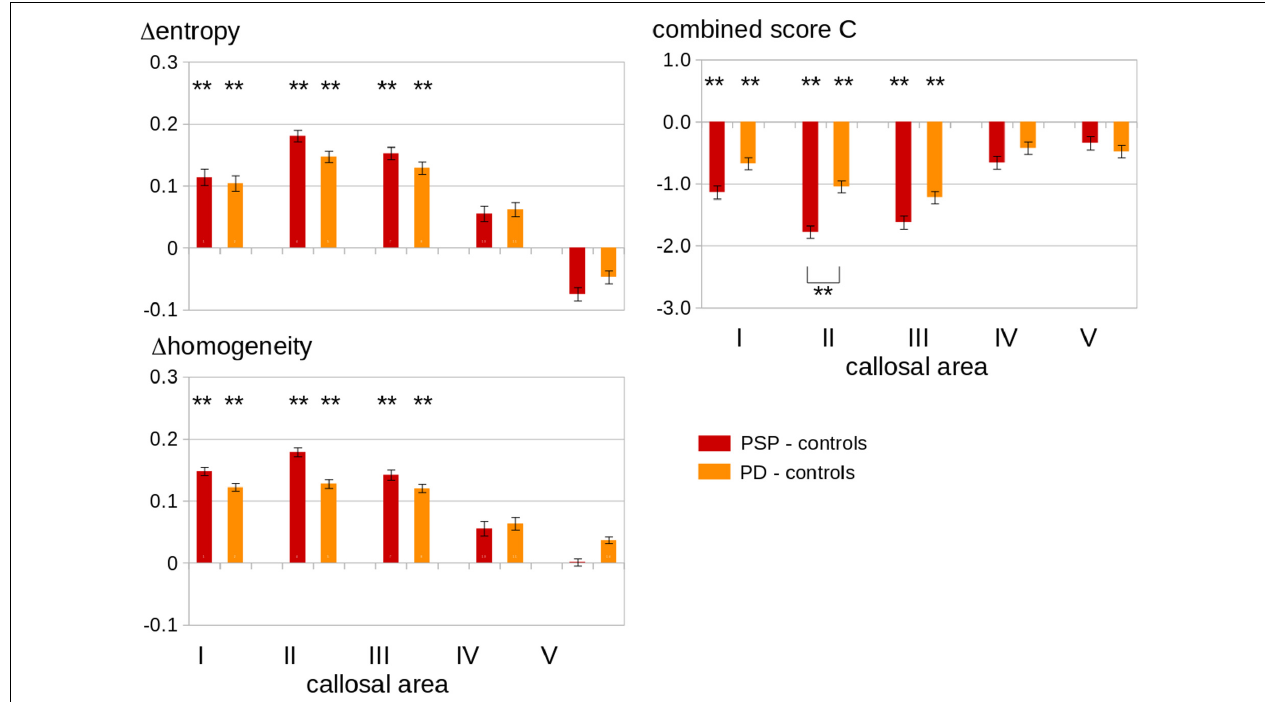
FIGURE 3 | Left Panel: Texture results for CC areas I–V in the patients with PSP as compared to patients with PD and to healthy controls. Displayed are the differences ( (cid:49) ) in average values of the parameters entropy and homogeneity between the two patient groups and the controls. PSP patients showed an increased entropy and homogeneity of CC area I, area II, and area III compared to controls. Entropy and homogeneity of CC area I, area II, and area III were increased in PD compared to controls. Right panel: Combined score C (see Eq. 1) results for CC areas I-V in the patients with PSP as compared to the patients with PD and to healthy controls. Displayed are the differences ( (cid:49) ) in average C values between patient groups and controls. PSP patients and PD patients showed increased C values in callosal areas I, II, and III compared to controls, while areas IV and V showed no significant differences. Significant differences between PSP patients and PD patients were shown by brackets below the column (only for callosal area II). Error bars are the standard error of the mean. ** p < 0.001, corrected for multiple comparisons.